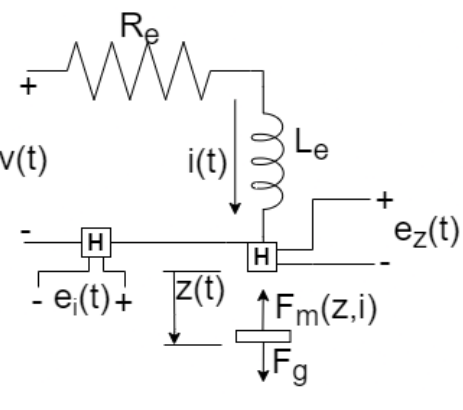
Figure 5. Eletromagnetic